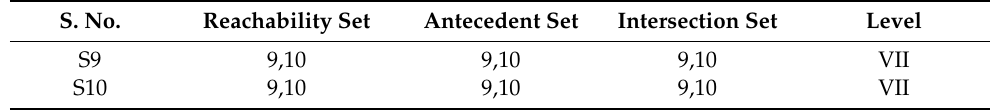
Table A7. Level partitions (Iteration